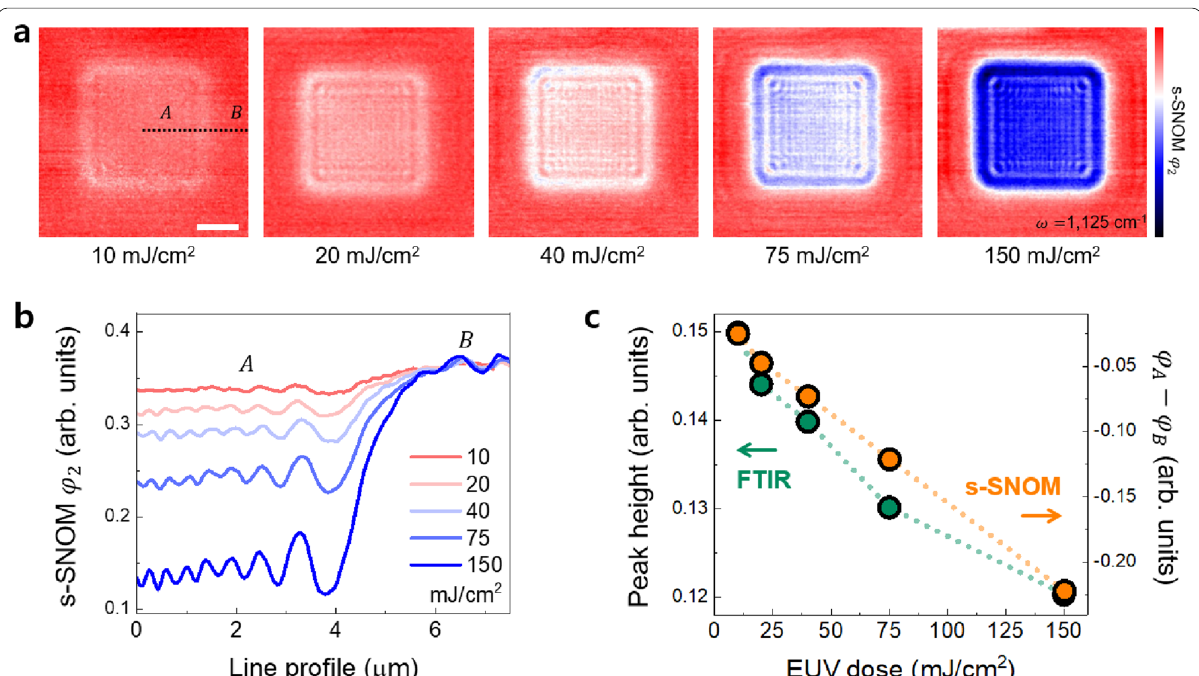
Fig. 2 a EUV dose‑dependent s‑SNOM chemical imaging results. The red color indicates higher infrared absorption. The scale bar is 3 μm. b Line profiles taken from the image in ( a ) as indicated by the black dotted line. A and B respectively indicate EUV‑exposed and non‑exposed areas. c Comparison of the peak height of the cage‑like structure from FTIR spectra and phase differences ( ϕ A − ϕ B ) of s‑SNOM at 1125 cm − 1